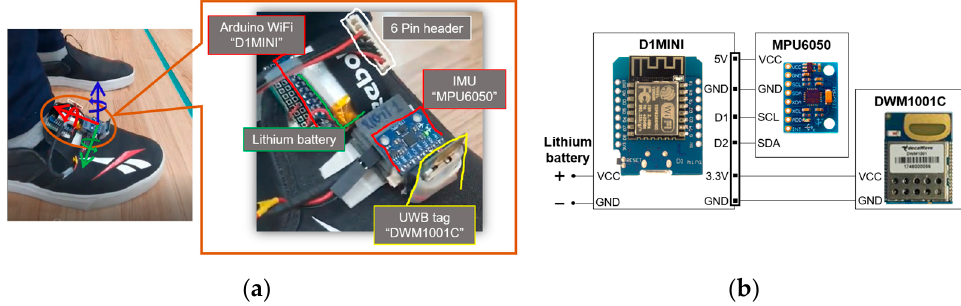
6 of 18 Figure 3. Infrastructure layout and concept of UWB positioning system. 2.1.3. Wearable IoT Device: A Low-Cost Foot-Placed UWB and IMU Module To qualify as an IoT device, our designed prototype is compact-sized, battery-pow- ered, and capable of communicating both with fellow devices and a central computer over a wireless interface such as UWBs and WiFi, respectively. Our module, as shown in Figure 4a, is placed on the right shoe of the pedestrian. It includes a DWM1001C as the UWB tag, a D1MINI (WEMOS, China) as the WiFi transceiver, an MPU6050 (InvenSense, USA) as the IMU, and a lithium battery 650 mAh as the power source. The lithium battery is di- rectly connected to D1MINI which further powers the DWM1001C at 3.3 V. In addition, both the DWM1001C and D1MINI can also process information onboard. The DWM1001C